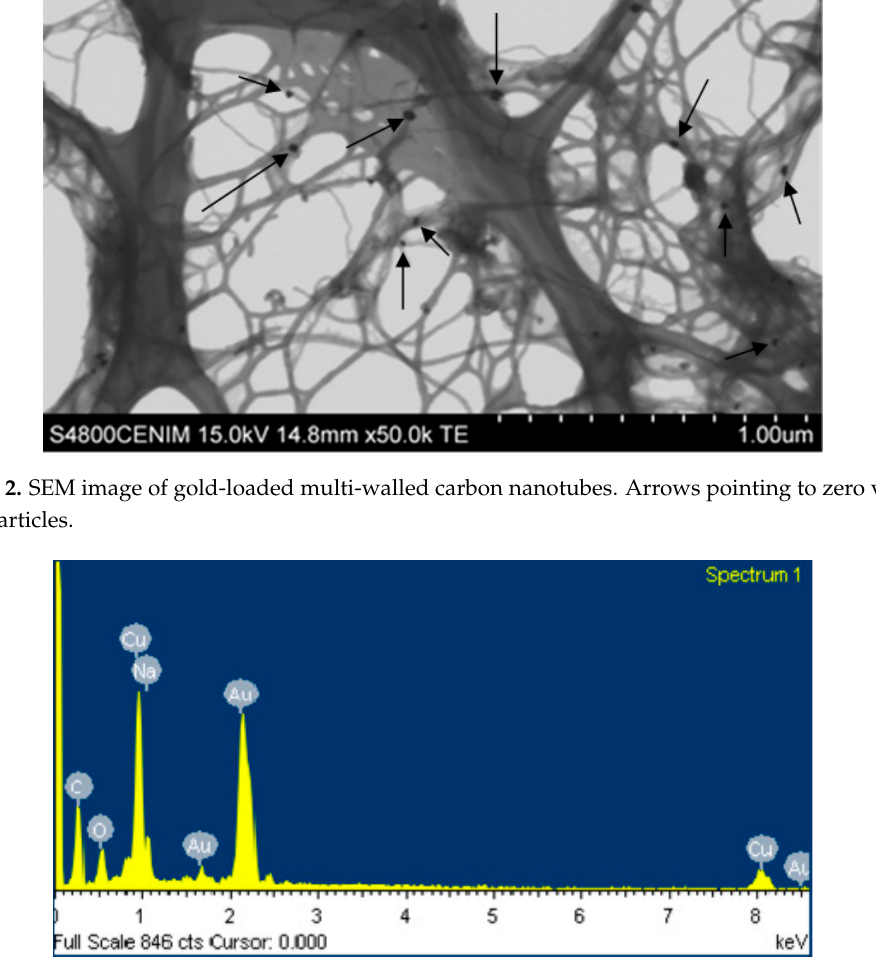
Figure 3. Energy Dispersive X-ray Spectroscopy spectrum of the dark particles (zero valent gold) of Figure 2.